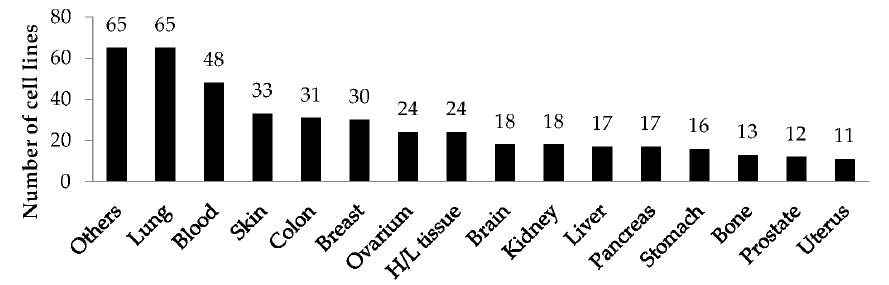
Figure 1. Distribution of 438 cell lines by organs and tissue.